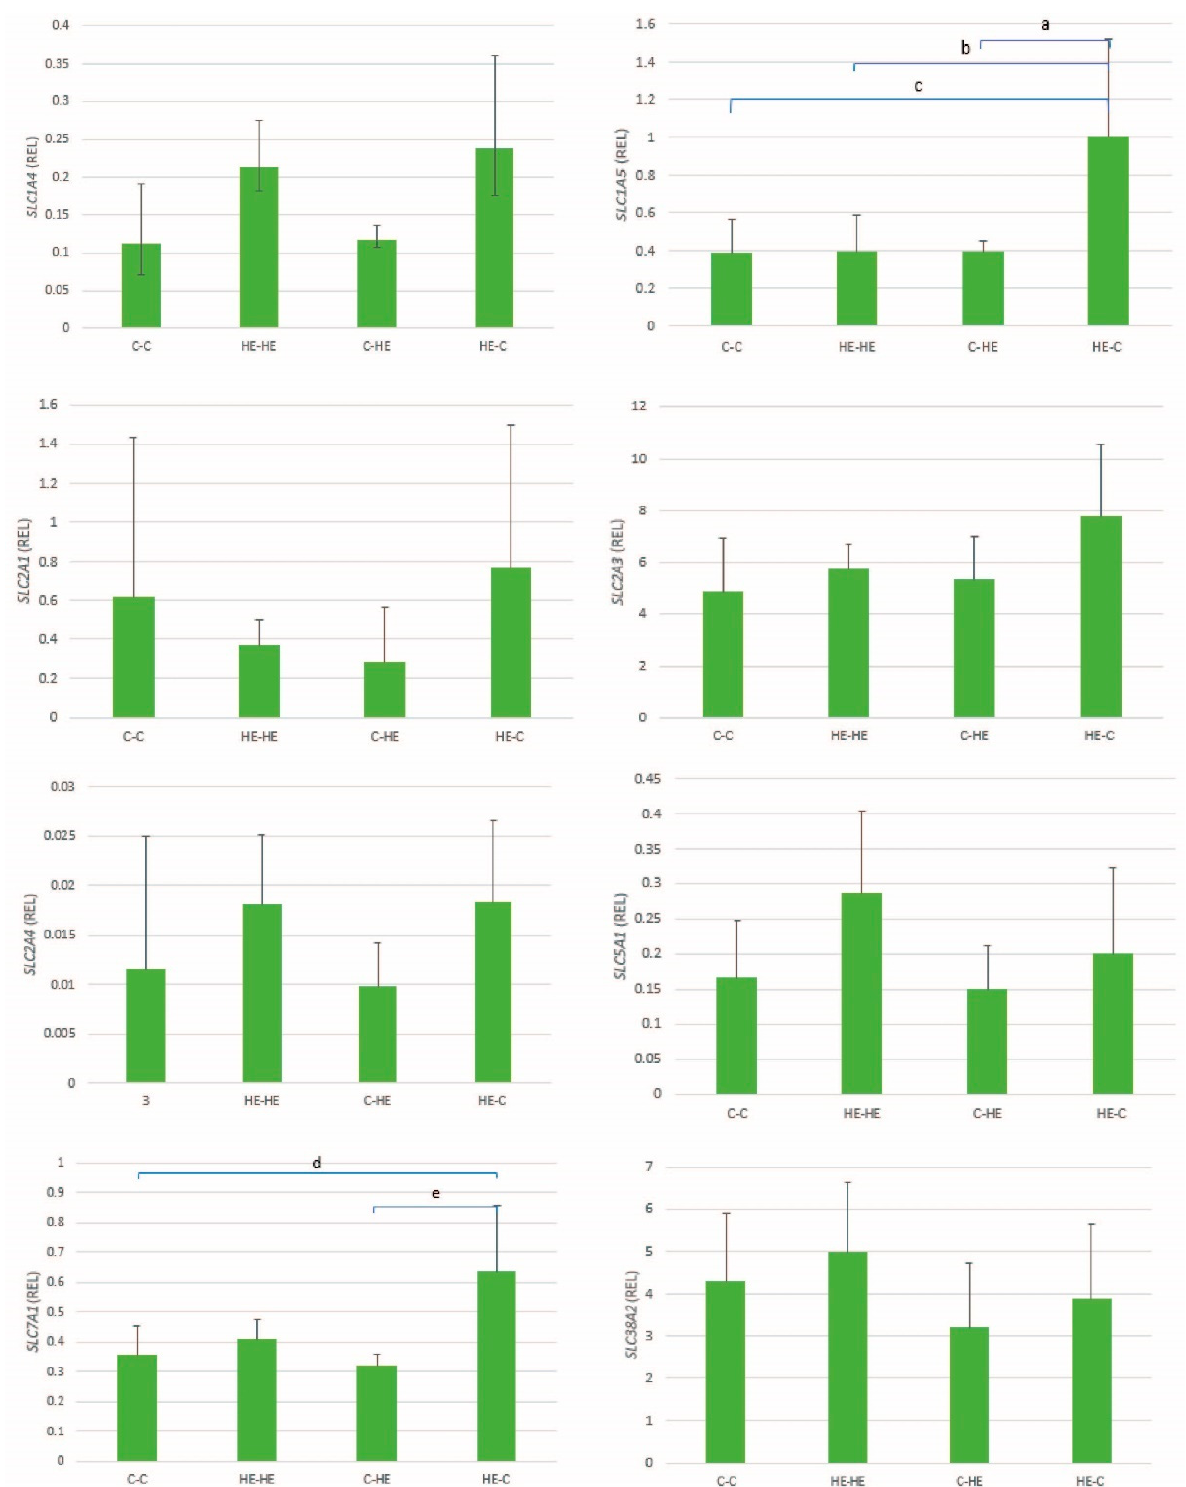
Figure 8. Mean ± SD relative gene expression (REL) for a selection of glucose and amino-acid transporters in the endometrium of recipient Shetland pony mares at day 28 of conceptus development, after transfer of day-7 embryos from a control (C) to a control mare (C-C; n = 4), high-energy (HE) to HE mare (HE-HE; n = 4), control to HE mare (C-HE; n = 4) or HE to control mare (HE-C; n = 4). a p = 0.002; b p = 0.003; c p < 0.001; d p = 0.01; e p = 0.003.